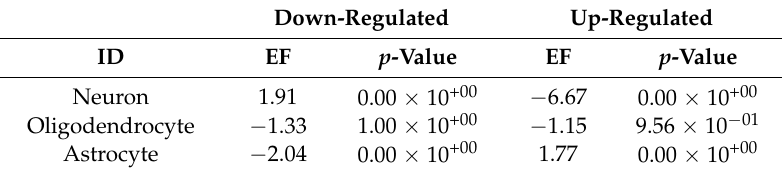
Table 5. Signature analysis of specific markers of neuron, oligodendrocyte and